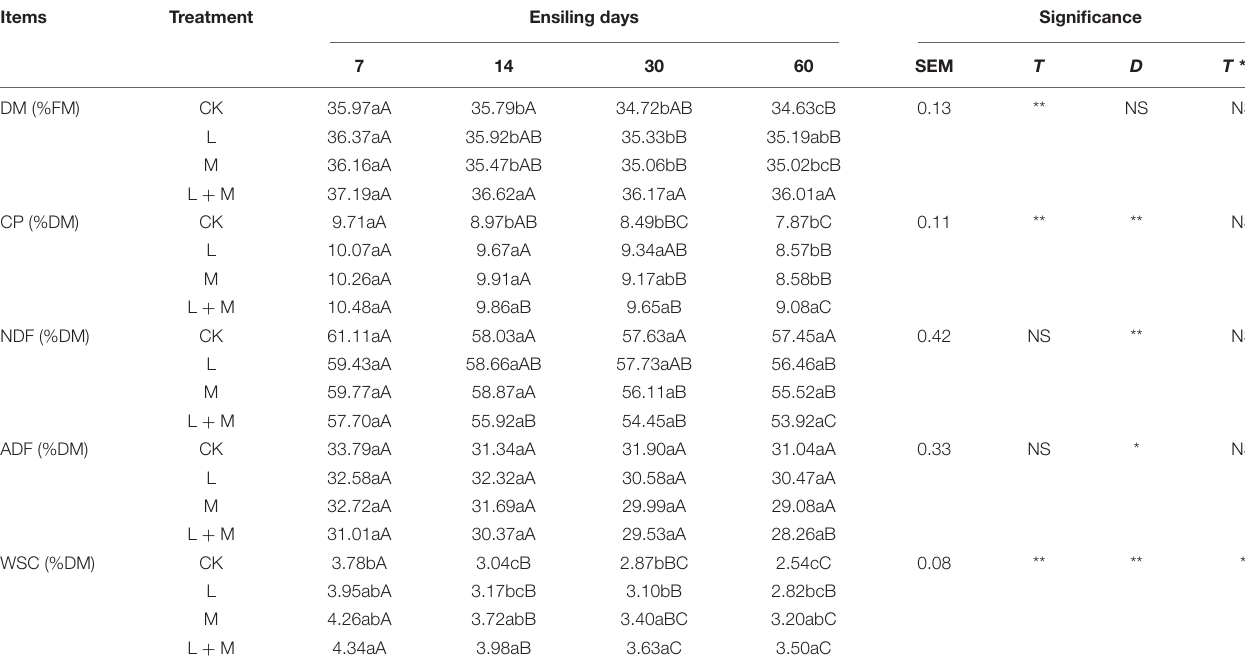
TABLE 2 | Effect of additives and ensiling days on chemical compositions of native grass silages. Items